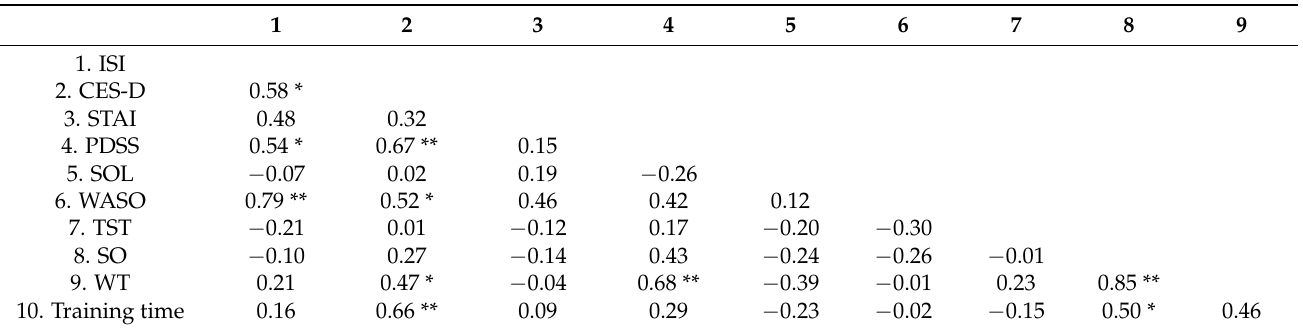
Table 4. Non-parametric correlations between variables measured.